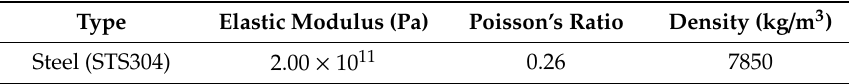
Table 4. Physical properties of the magnetic coupler (bulk head and outer rotor).